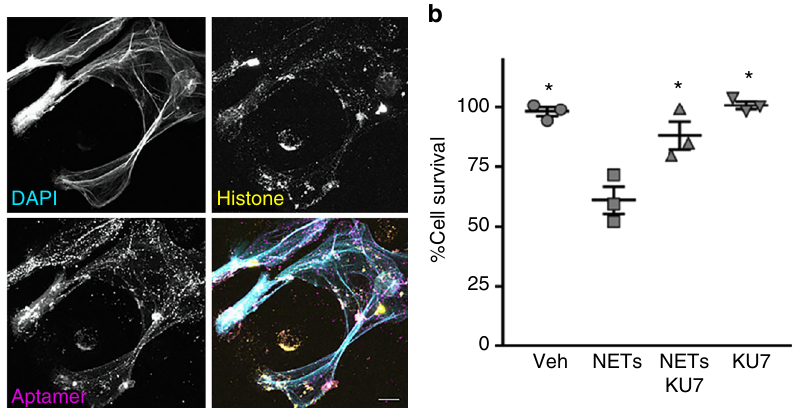
Fig. 6 Aptamers bind to human neutrophil-derived NETs and inhibit NET-induced cytotoxicity. a Confocal microscopy of human neutrophil-derived NETs. Single images are shown in gray scale. DAPI (top, left); histones (top, right); aptamer KU7 (bottom, left); merged images show: cyan, DAPI labeling of DNA, yellow, histones, and magenta, aptamer KU7 – 647 (bottom, right). White areas in the merged image represent close proximity of DNA, histone and aptamer. Representative images, captured with 40× oil and 2.8× zoom. Scale is equivalent to 10 µ m. b Aptamer inhibition of NETs-mediated cytotoxicity of endothelial cells determined by MTS assay. EA.hy926 cells treated with 8 µ g per well of NETs material (based on DNA concentration) and/or 8 µ g per well (10.66 µ M) of aptamer (KU7); * p < 0.01 vs. NETs, one-way ANOVA corrected for multiple comparisons (Tukey), n = 3, data represent mean ±